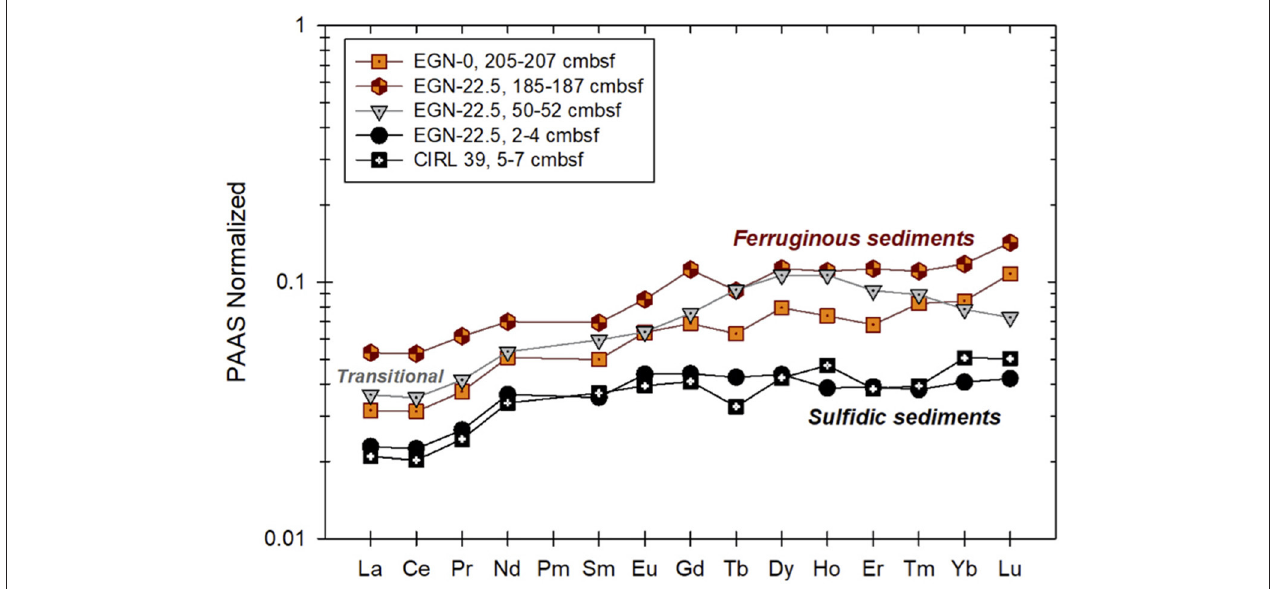
FIGURE 5 | PAAS-normalized REE patterns of sediment collected from the Indian River Lagoon subterranean estuary. Individual samples are color coded to reflect the color of the sediments during collection [see Figure 2 from Roy et al. (2011)]. Ferruginous sediments are from the portion of the subterranean estuary where Fe(III) reduction predominates (Fe production zone), whereas the sulfidic sediments were collected from just below the seafloor where sulfate reduction predominates and Fe sulfide minerals (presumable mackinawite) precipitates. The “transitional” sediment sample was obtained where dissolved Fe mobilized in the deeper, ferruginous sediments is re-adsorbed (see Roy et al., 2011 for details).